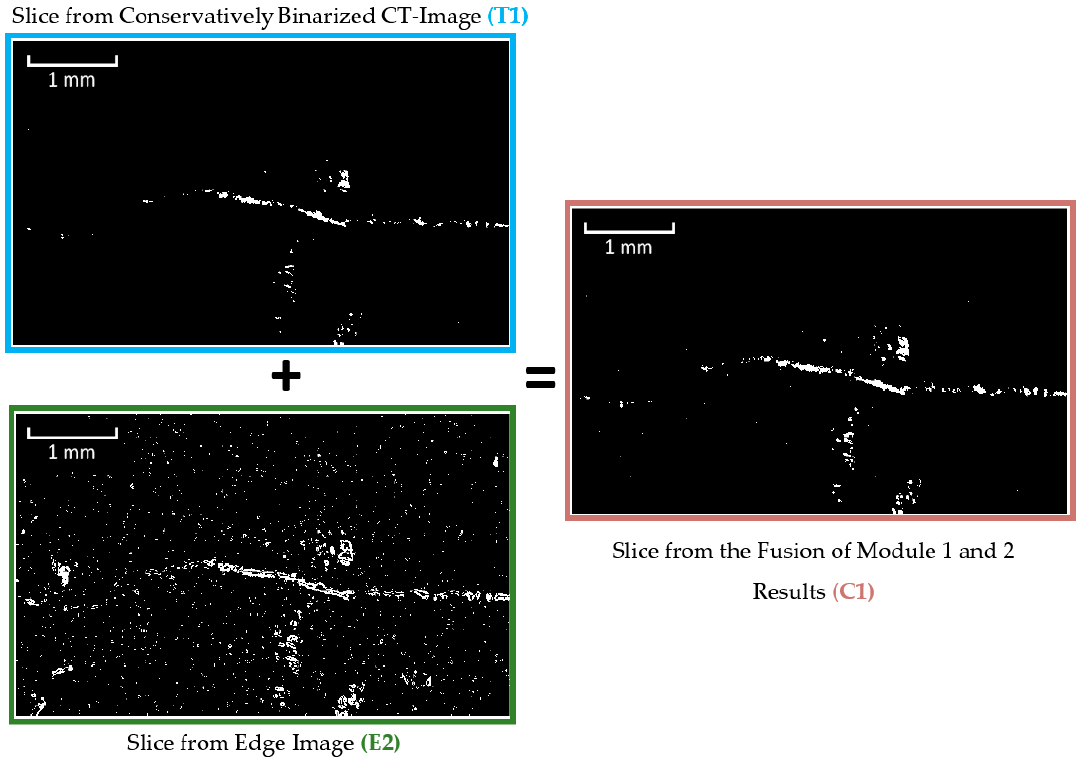
Figure 10. Fusion of images resulting from Modules 1 and 2 (based on figure in [10]).